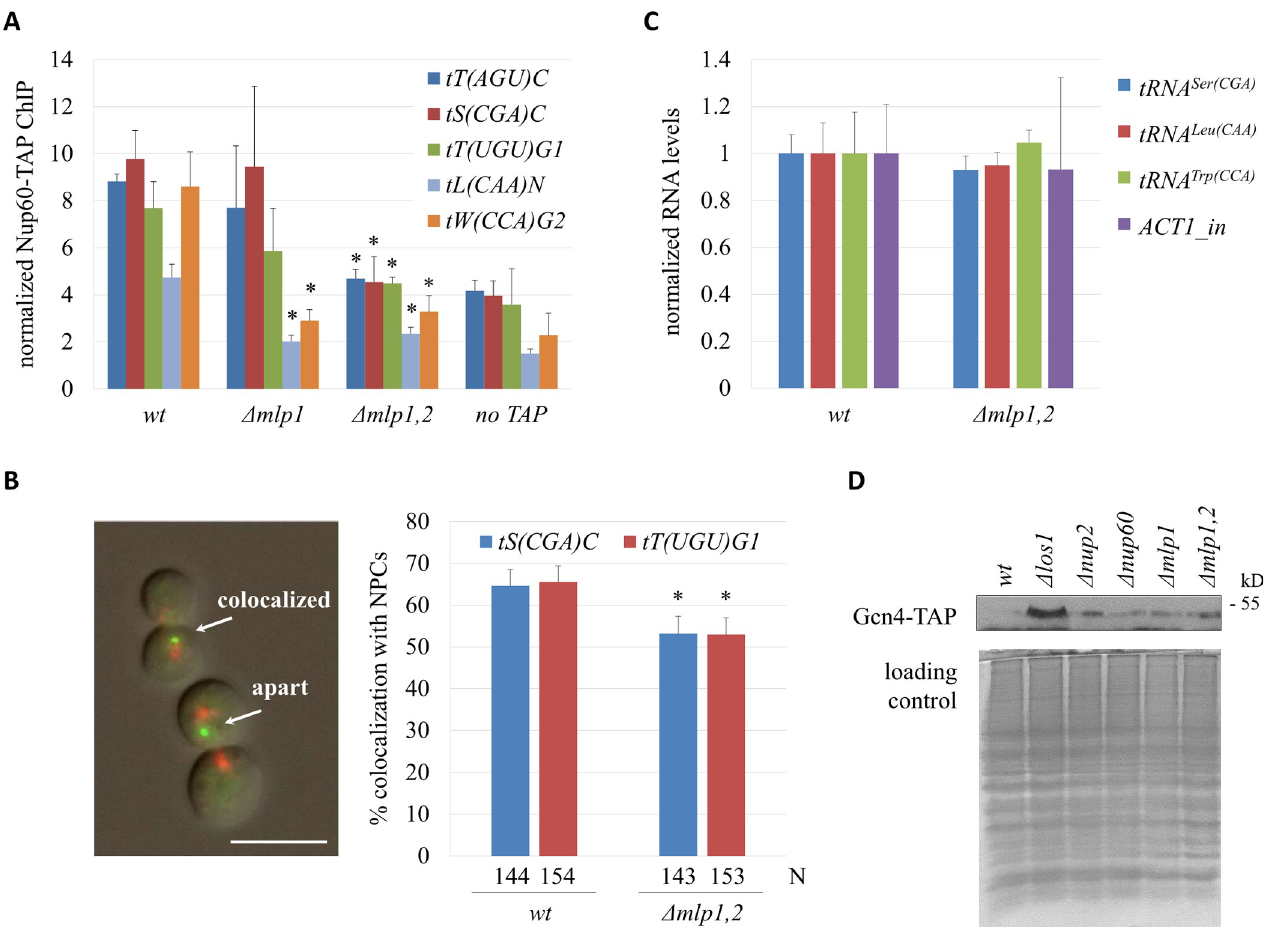
Fig 1. TPR orthologs in yeast contribute to tRNA export. (A) Binding of Nup60 at tRNA genes. ChIP-qPCR of Nup60-TAP was performed with strains MC177 ( wt ), MC273 ( Δ mlp1 ), MC276 ( Δ mlp1 , 2 ), and MC172 ( no TAP ) after M phase arrest by CDC20 depletion, when Nup60 was known to have increased association with tRNA genes in the wt strain. Data (mean ± SD, n = 3) were analyzed by Student’s t -test in paired comparison with the same tRNA gene in the wt strain; � P < 0.05. (B) tRNA gene-NPC association. Strains MC199 [ tS(CGA)C :: 256lac op ], MC200 [ tT(UGU)G1 :: 256lac op ], MRG7425 [ tS(CGA)C :: 256lac op Δ mlp1 , 2 ], and MRG7426 [ tT(UGU)G1 :: 256lac op Δ mlp1 , 2 ] were examined after M-phase arrest. Colocalization was defined as GFP and RFP foci were separated by no more than the width of the GFP spot. Scale bar = 10 μ m. N denotes the number of cells analysed. Pairwise χ 2 -tests, � P < 0.05. (C) Nascent tRNA levels. RT-qPCR was done with strains MC177 ( wt ) and MC276 ( Δ mlp1 , 2 ) after arrest in M phase to measure the levels of three representative pre-tRNAs and nascent ACT1 mRNA. Values were normalized to mature ACT1 mRNA. (D) Western blot to detect the expression of Gcn4-TAP in asynchronously grown cultures of strains MC341 ( wt ), MC343 ( Δ los1 ), MC349 ( Δ nup2 ), MC350 ( Δ nup60 ), MC344 ( Δ mlp1 ) and MC345 ( Δ mlp1 , 2 ). Coomassie blue staining was used to show even amount of protein loaded in